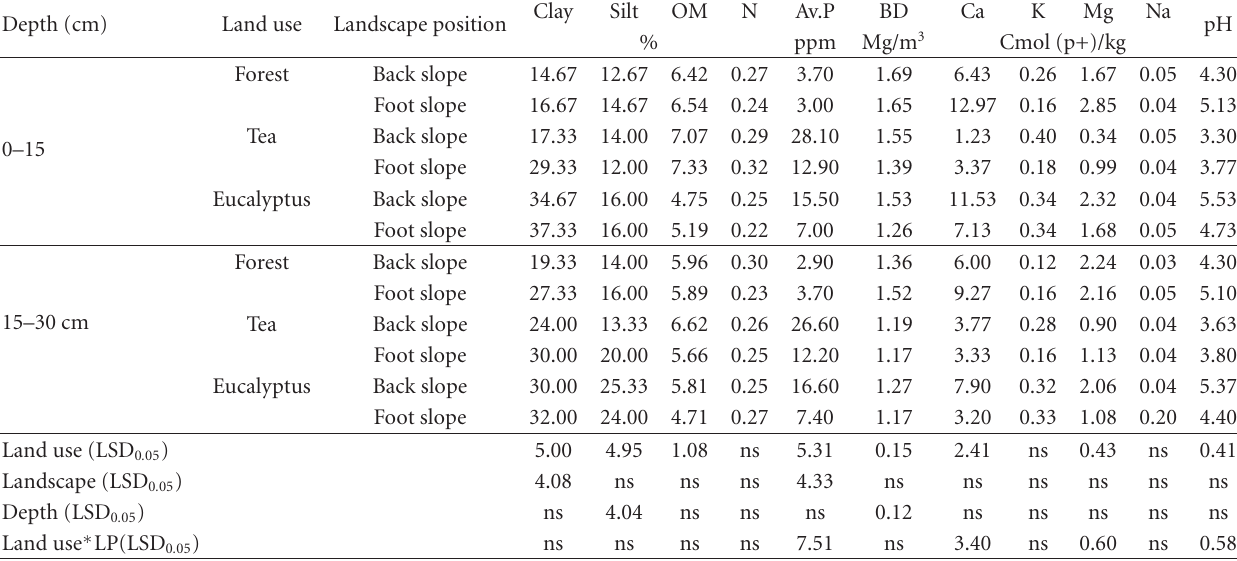
Table 4: E ff ect of land use/cover change on selected physicochemical